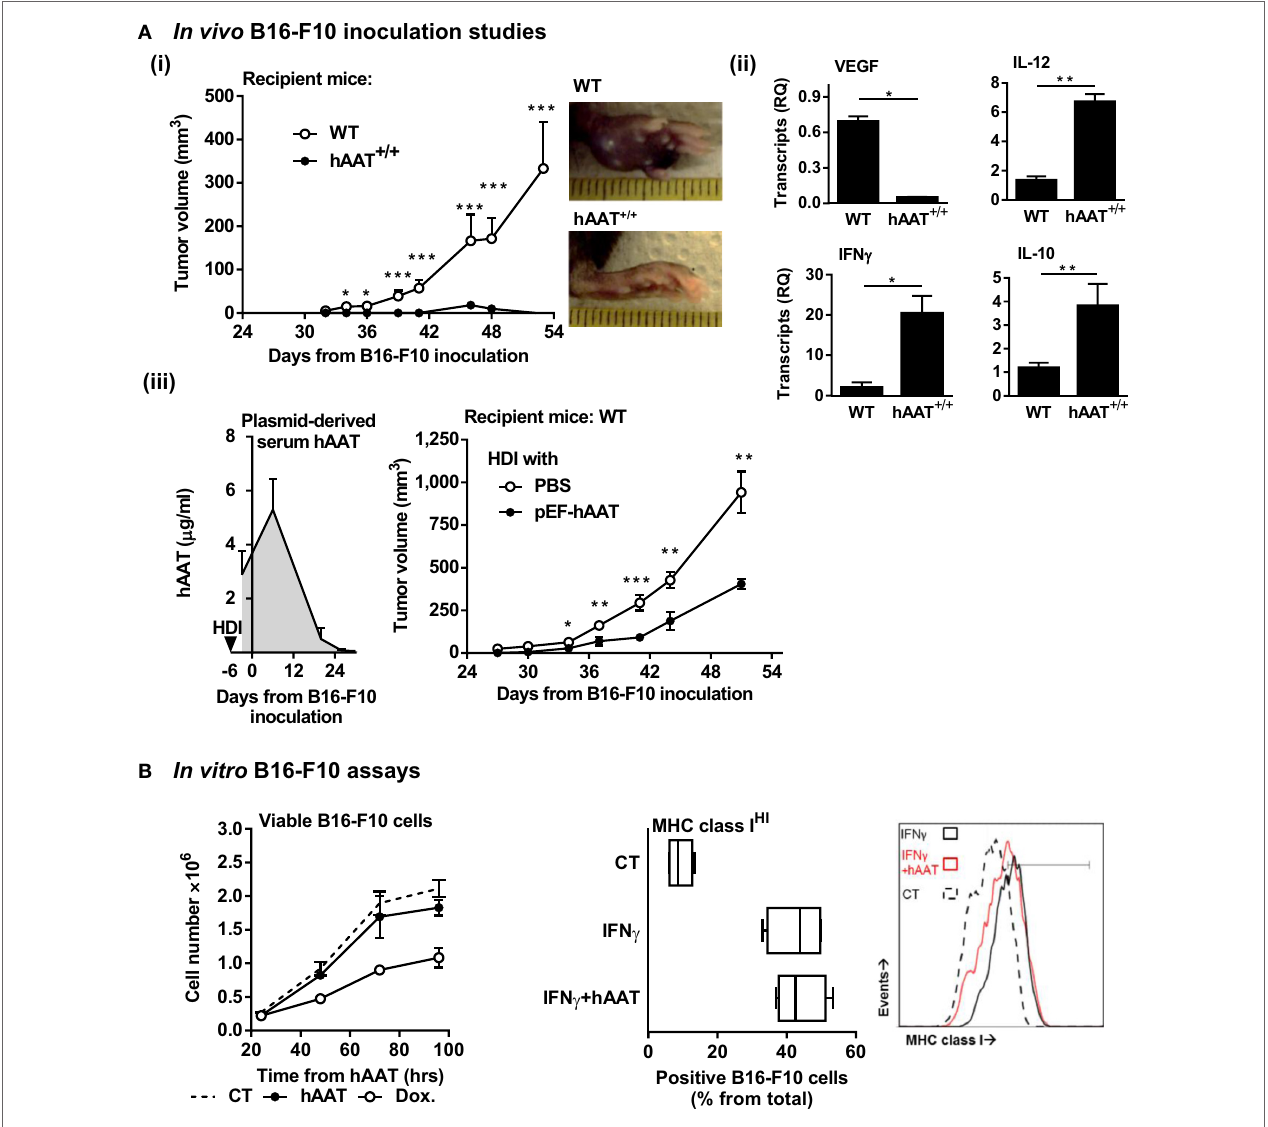
FigUre 1 | Plasma and plasmid-derived haaT inhibit in vivo development of primary B16-F10 tumors . (a) (i) hAAT + / + and C57BL/6 mice ( n = 10 and 11 per group, respectively) were inoculated i.f.p . with B16-F10 melanoma cells (5 × 10 4 cells per mouse). Footpad tumor size and representative day-38 footpad tumor photomicrographs. (ii) On day 21 after inoculation of C57BL/6 and hAAT + / + mice, total tumor RNA was purified, and transcription levels of designated genes were determined. Mean ± SEM, * p < 0.05, ** p < 0.01, *** p < 0.001. Unpaired two-tailed Student’s t -test was employed to assess differences between groups at each time point. (iii) C57BL/6 mice ( n = 8 per group) were introduced PBS or pEF-hAAT by hydrodynamic tail–vein injection. Six days later, mice were inoculated with B16-F10 cells i.f.p . (5 × 10 4 cells per mouse). Circulating serum levels of hAAT and tumor size follow-up. Triangle, time of in vivo plasmid introduction. (B) Left : B16-F10 cells (3 × 10 5 cells in triplicate) were pretreated in vitro with hAAT (0.5 mg/ml) or doxorubicin (60 μ M), and cell numbers were counted at indicated time points. Mean ± SEM. Right : B16-F10 cells (3 × 10 5 cells in triplicate) were pretreated with hAAT (0.5 mg/ml) for 24 h and then stimulated with IFN γ (10 ng/ml) for 24 h. Cells were then stained for MHC class I and analyzed by flow cytometry. Mean ±